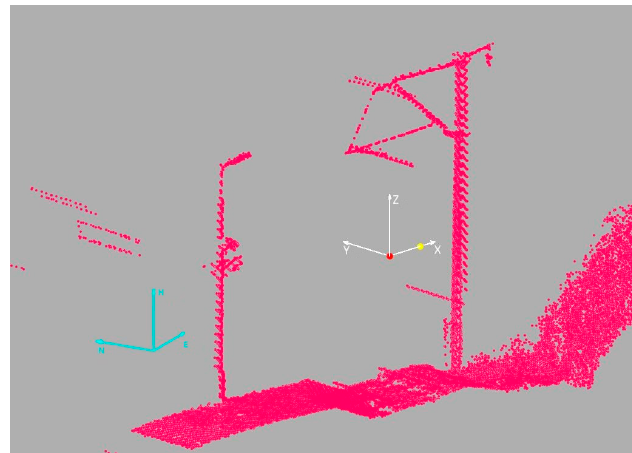
Figure 8. Sample point cloud section. Easting, northing, elevation (ENH) coordinate system in teal, section local coordinate system in white, section key point in red, section directional point in yellow.